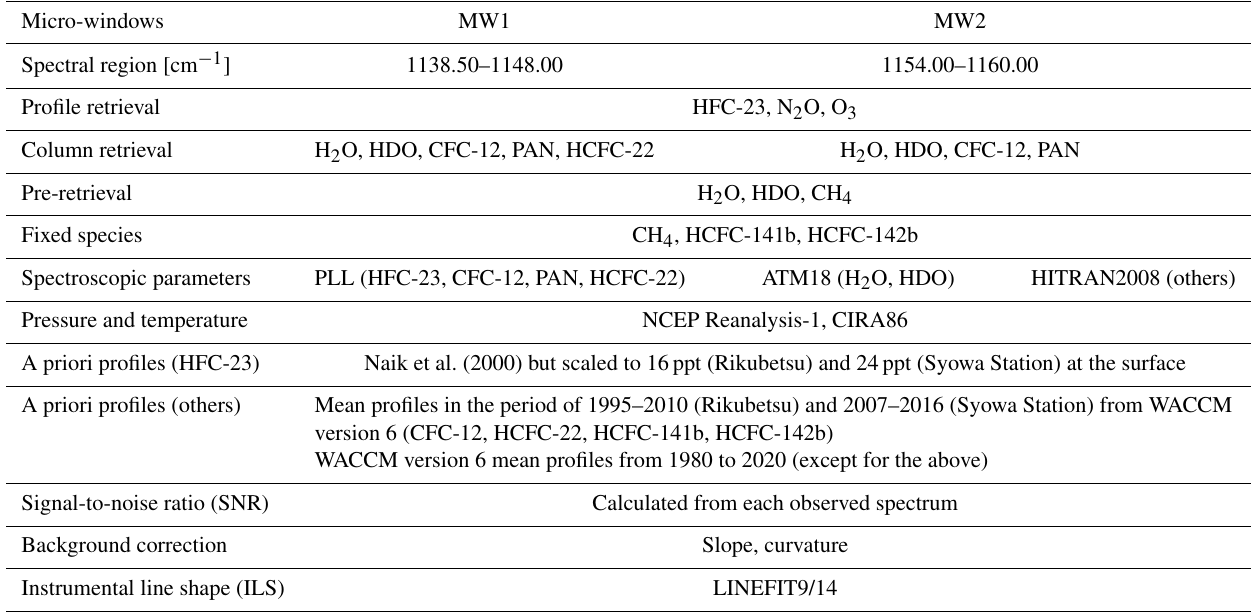
Table 1. Summary of settings used for HFC-23